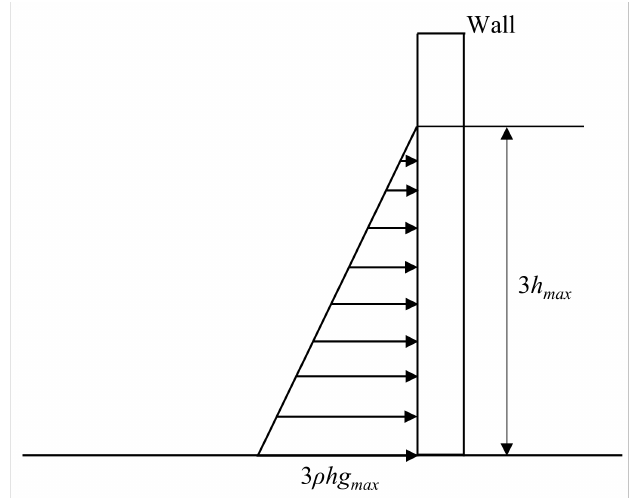
Figure 1. Tsunami force calculation method in